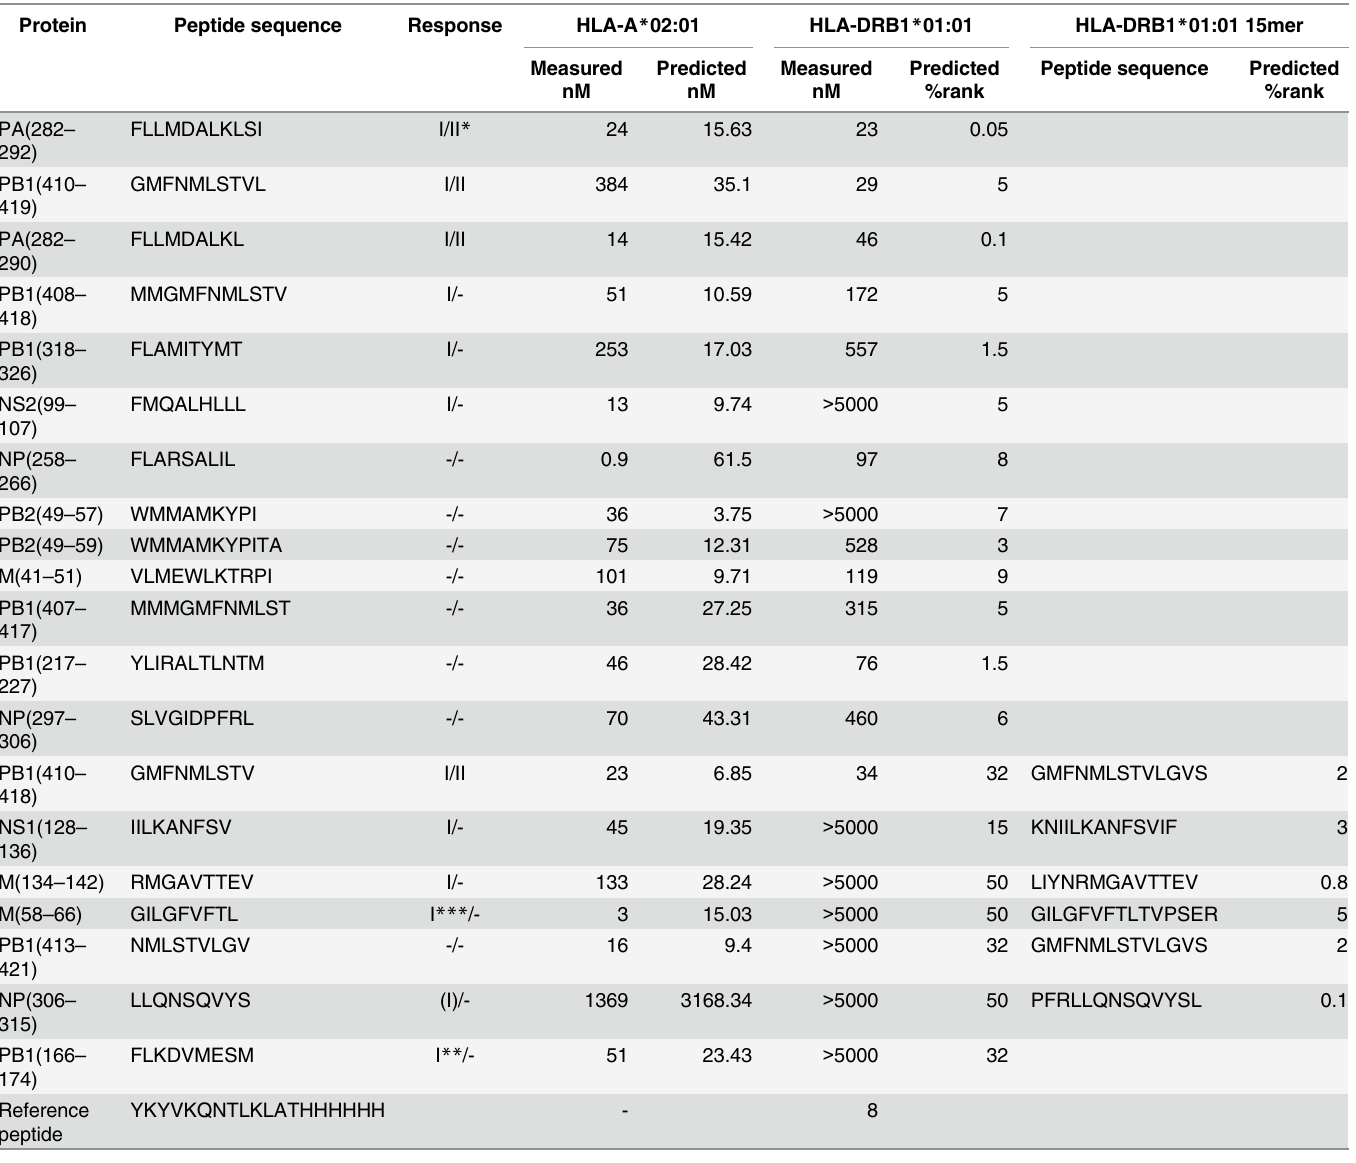
Table 1. Peptides predicted and measured for binding to HLA-A * 02:01 and HLA-DRB1 * 01:01. Protein Peptide